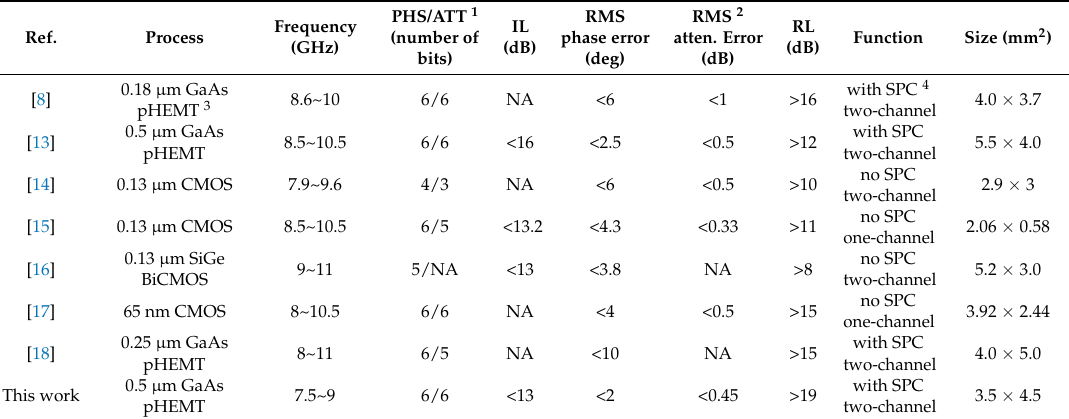
Table 4. Performance comparison of relevant multi-function chip